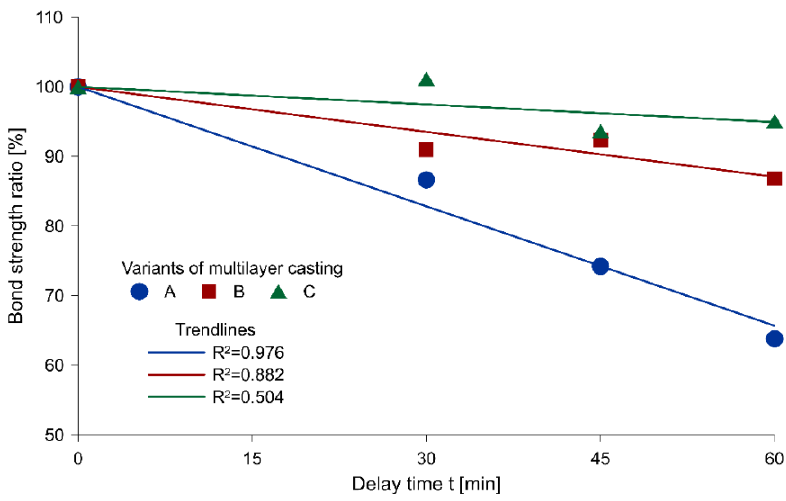
Figure 5. The relationship between the bond strength ratio and delay time of successive layers.